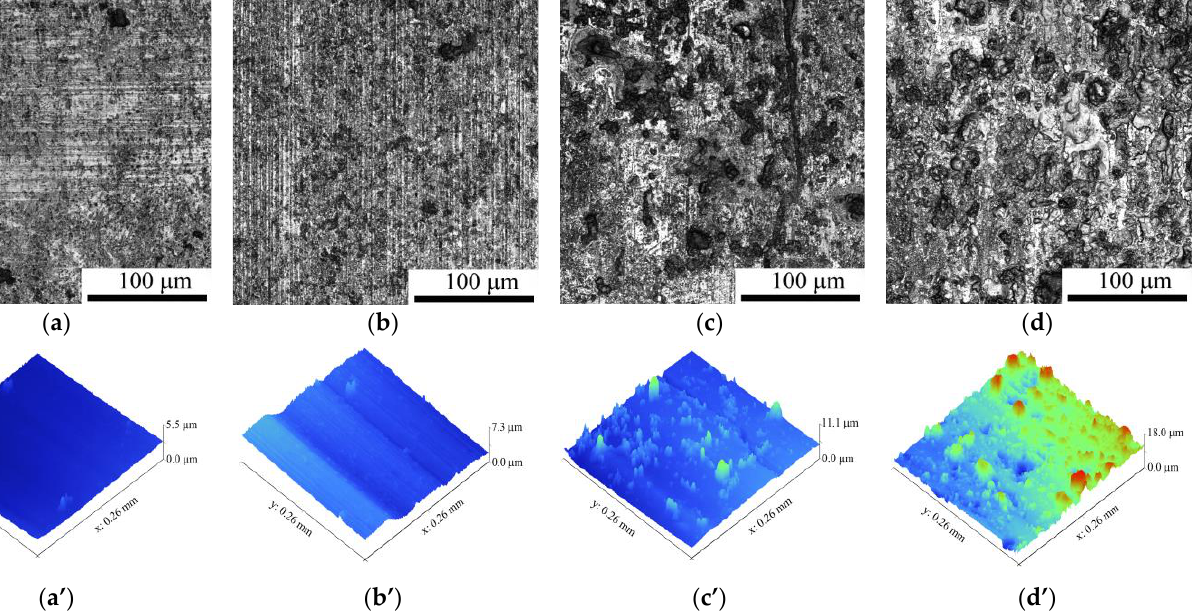
Figure 6. The optical images of worn surface ( a – d ) and 3D maps of the worn surface ( a’ – d’ ) of M2/W coating after sliding speeds of: 0.8 m/s ( a , a’ ); 1.2 m/s ( b , b’ ); 2.4 m/s ( c , c’ ); 3.6 m/s ( d , d’ ).